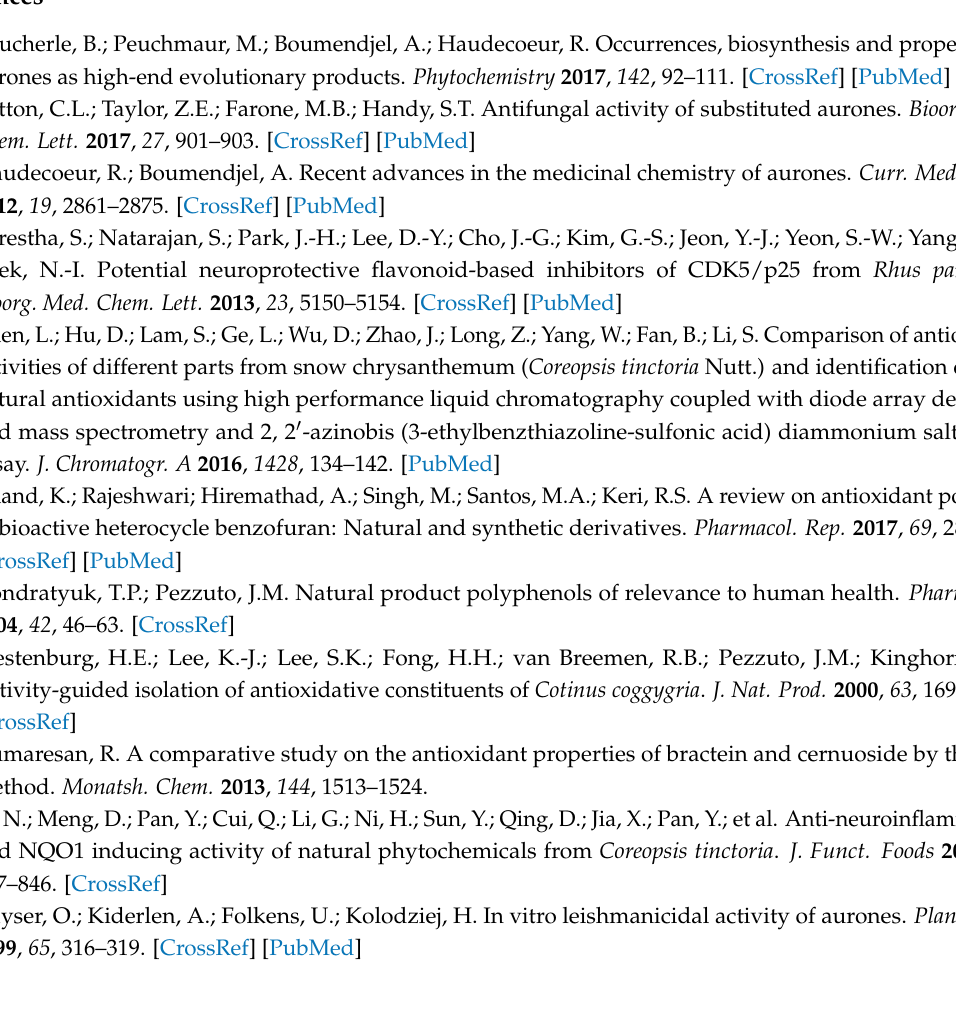
Figure S1: PCR product visualized on the agarose gel; Figure S2: List of conserved domain hits; Figure S3: Detection of the recombinant OsUGT1 by SDS-PAGE and Western-blotting; Figure S4: Mass spectra of metabolites 1a, 1b and 1c; Figure S5: 1 H NMR spectrum and 13 C NMR spectrum of 1a; Figure S6: HMBC spectrum of 1a; Figure S7: 1 H NMR spectrum and 13 C NMR spectrum of 1b; Figure S8: HMBC spectrum of 1b; Figure S9: 1 H NMR spectrum and 13 C NMR spectrum of 1c; Figure S10: HMBC spectrum of 1c; Figure S11: HPLC chromatogram of glucosylation of luteolin with OsUGT1 or without OsUGT1; Figure S12: The mass spectra of glucosylated metabolites 2a, 2b and 2c; Figure S13: HPLC chromatogram of glucosylation of 7,8-dihydroxyflavone with OsUGT1 or without OsUGT1; Figure S14: The mass spectrum of glucosylated metabolite 3a; Figure S15: HPLC chromatogram of glucosylation of 5,7-dihydroxyflavone with OsUGT1 or without OsUGT1; Figure S16: The mass spectrum of glucosylated metabolite 4a; Figure S17: HPLC chromatogram of glucosylation of 6-hydroxyflavone with OsUGT1 or without OsUGT1; Figure S18: The mass spectrum of glucosylated metabolite 5a; Figure S19: HPLC chromatogram of glucosylation of 3,2 (cid:48) -dihydroxyflavone with OsUGT1 or without OsUGT1; Figure